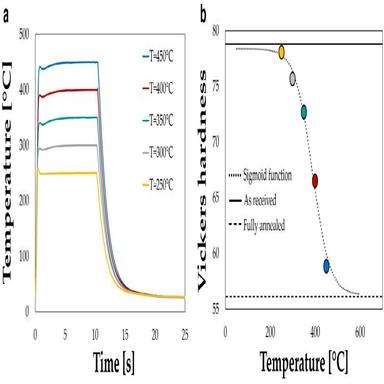
Results from annealing tests: (a) local temperature-time curves and (b) measured hardness distribution as a function of the peak temperature (i.e. at the soaking step).